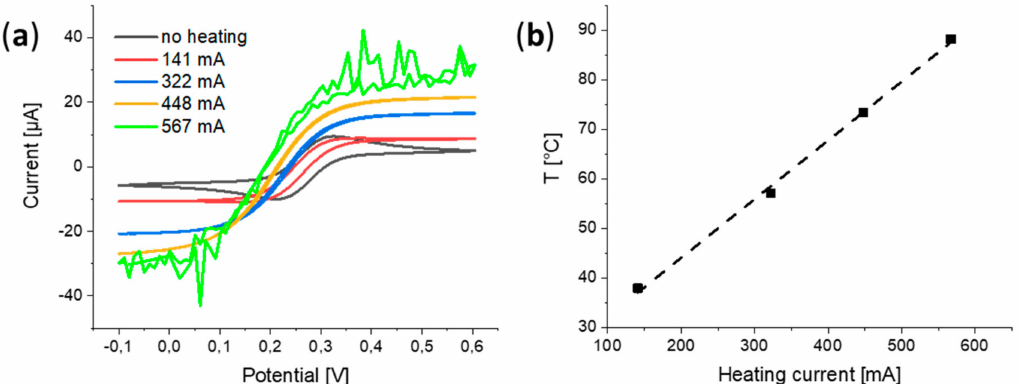
Figure 1. ( a ) Cyclic voltammograms (CVs) of a flattened Pt wire (width, 70 µ m) in 5 / 5 mM ferro / ferricyanide solution with 1.0 M KNO 3 as supporting electrolyte. The applied alternating current (AC) at the wire varied between the CVs. Scan rate: 100 mV / s. ( b ) Plot of heating currents applied at the wire during CVs and their respective temperatures, obtained from half-wave